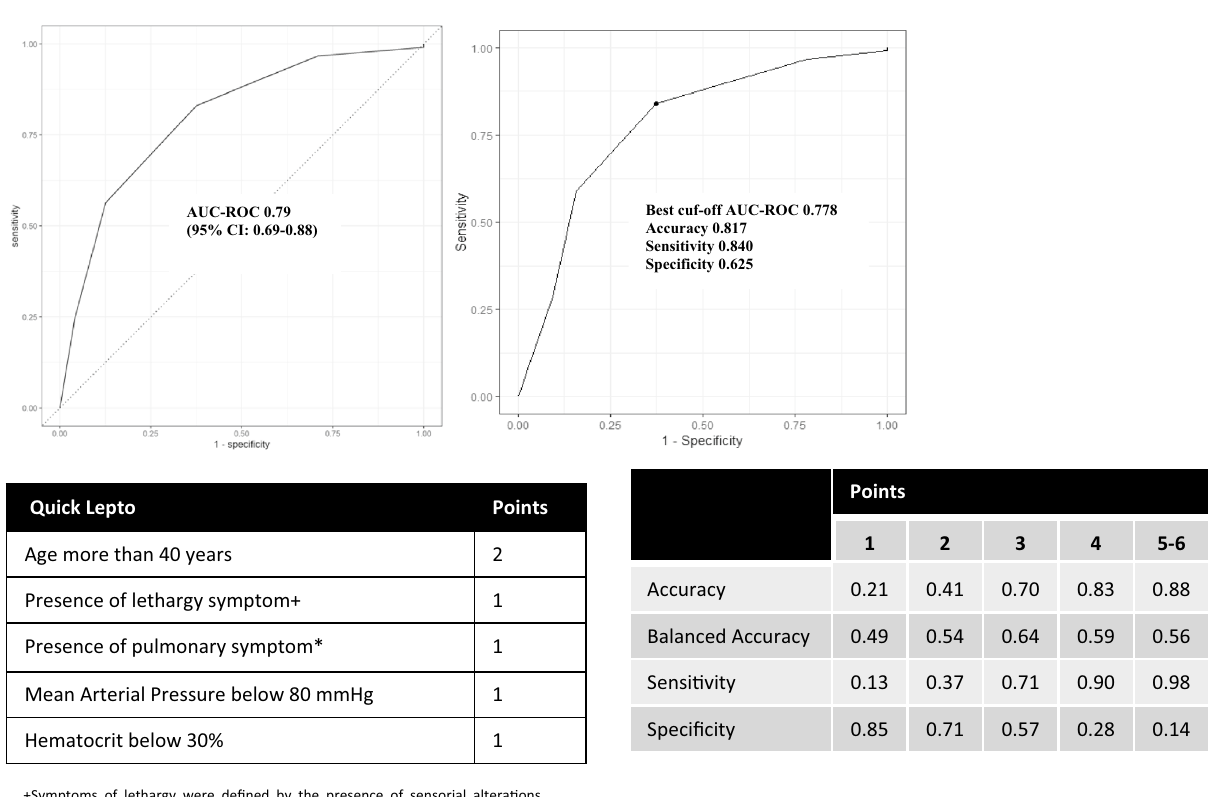
Figure 1. AUC-ROC curves of the QuickLepto in the validation cohort. A six-point scale and the discriminant measures of